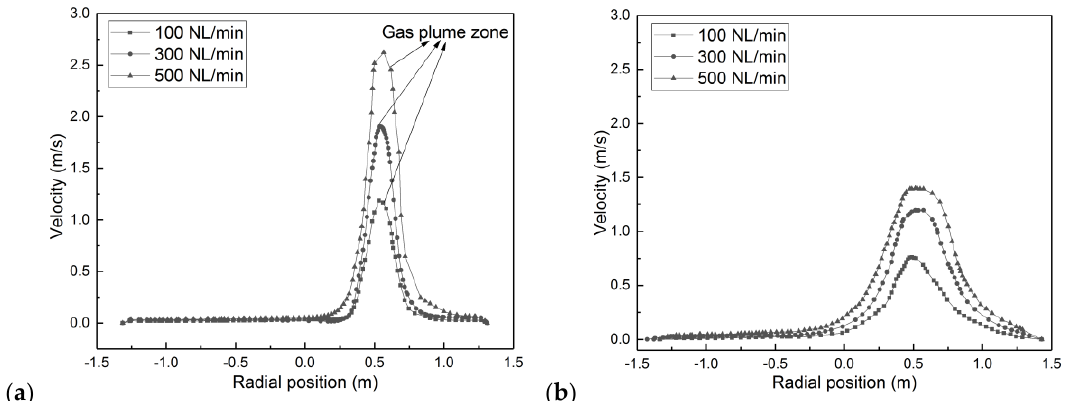
Figure 5. Velocity distribution profiles for different gas flow rates from the ladle bottom: ( a ) 1.5 m ( b ) 3.0 m.